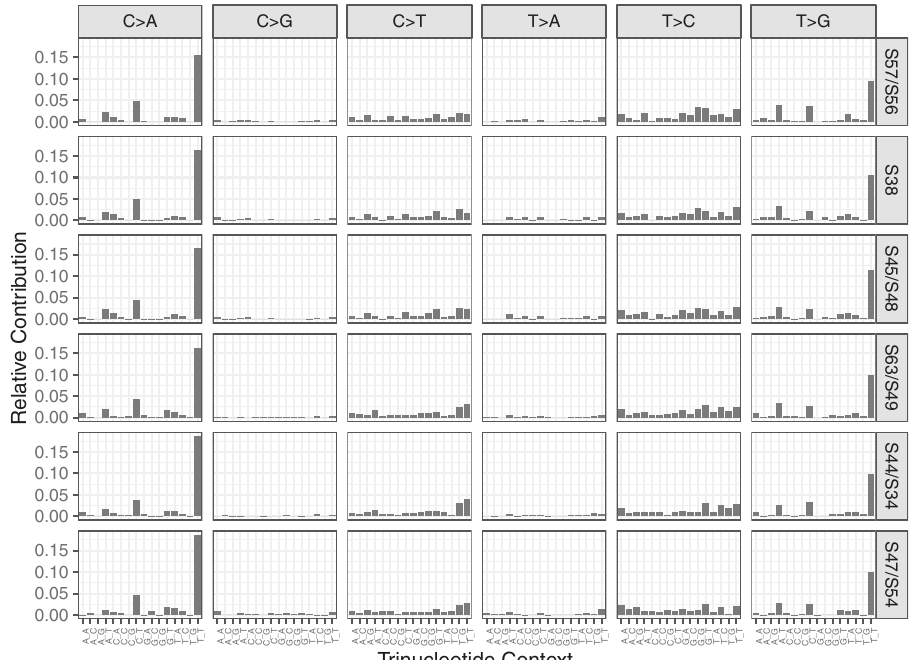
Fig. 3 Mutational signature across each leaf sample is consistent. Samples are shown with their sister sample since the lineage tree is used to validate the mutations there are no differences in validated sites between sister